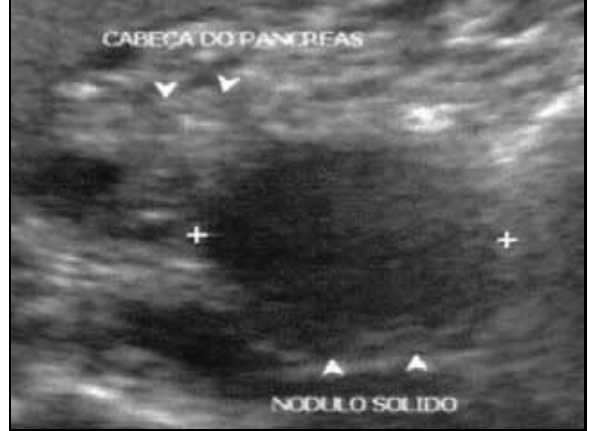
Figura 1 – Ecografia de pâncreas demonstrando TSPPP em topografia de processo uncinado TSPPP: tumor sólido pseudopapilar de pâncreas.